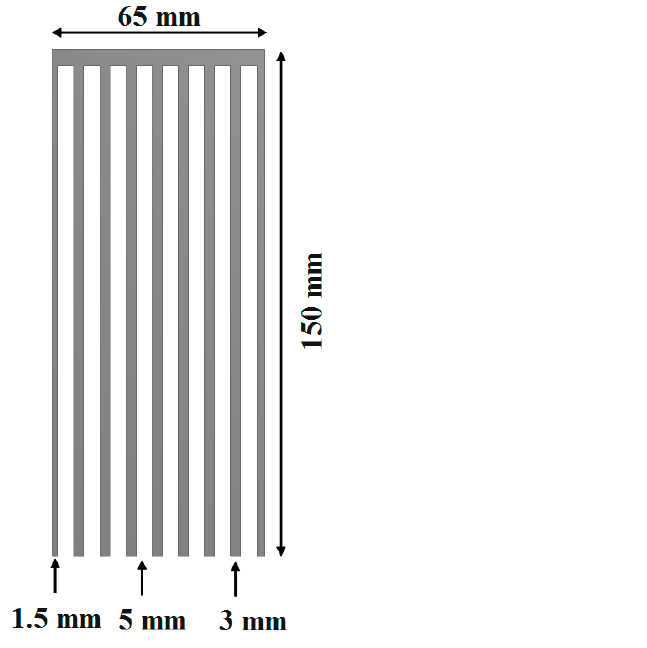
Figure 4. Structure and parameters of the DF-PCHE channels. An unstructured grid was used as the computational grid in the geometrical model. A grid refinement was performed near the walls, with the y plus less than 1, as shown in Figure 5. There are three types grids (2,730,000, 4,150,000, and 5,260,000) that are used for grids independence test, the α values for 3 × 3 SPB at ∆ L = 100 mm are 1.393, 1.267, and 1.254, respectively. According to the α values results, the total number of grids is determined to be 4,150,000.